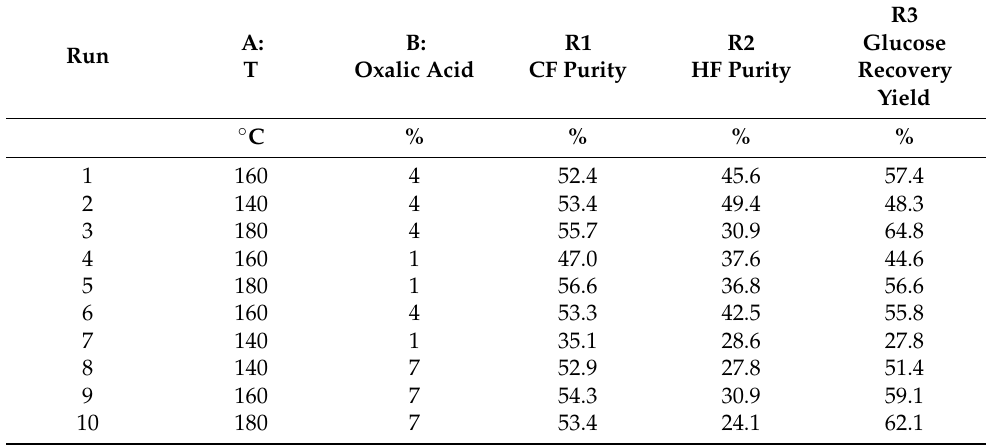
Table 4. Design of experiment for WS pretreatment with 2M-THF and obtained experimental responses.